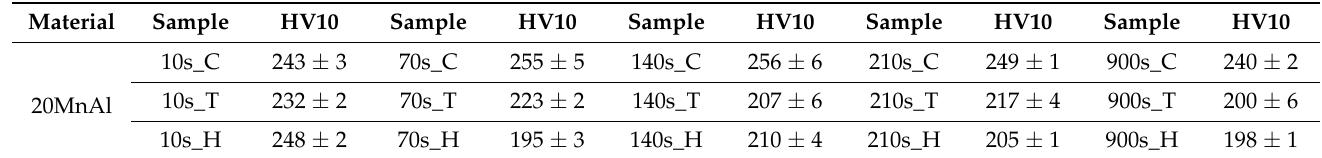
Table 4. Hardness of 20MnAl steel in different parts of the sheet.